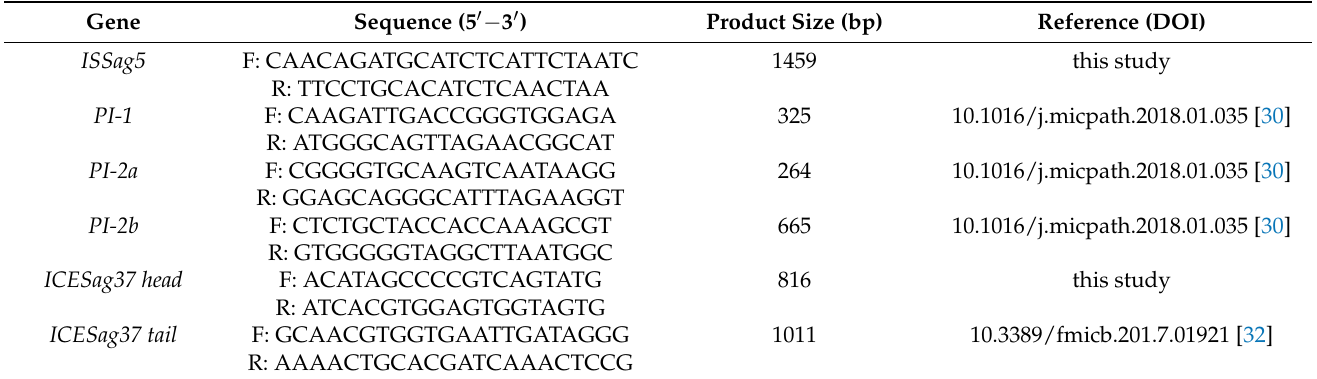
Table 1. Principal oligonucleotide primers used in this